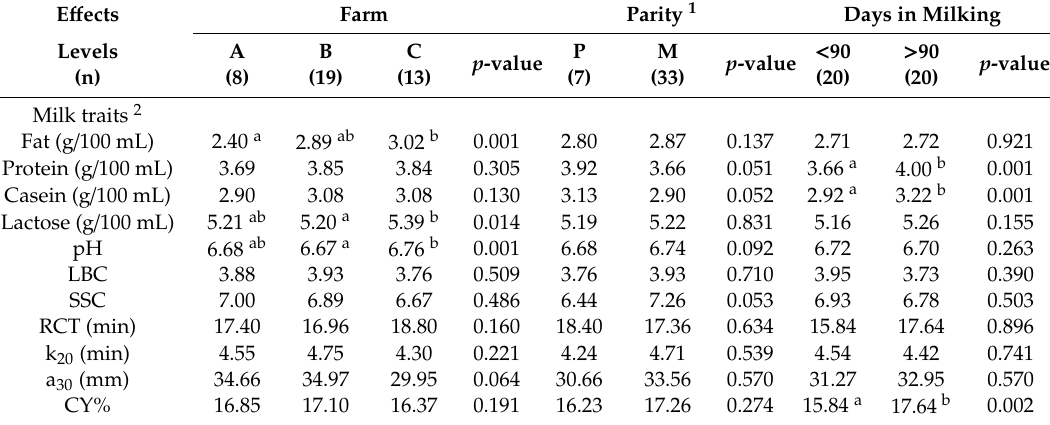
Table 2. Least square means of milk traits from Sardo-Modicana cows (n = 40) and significance according to the phenotypic e ff